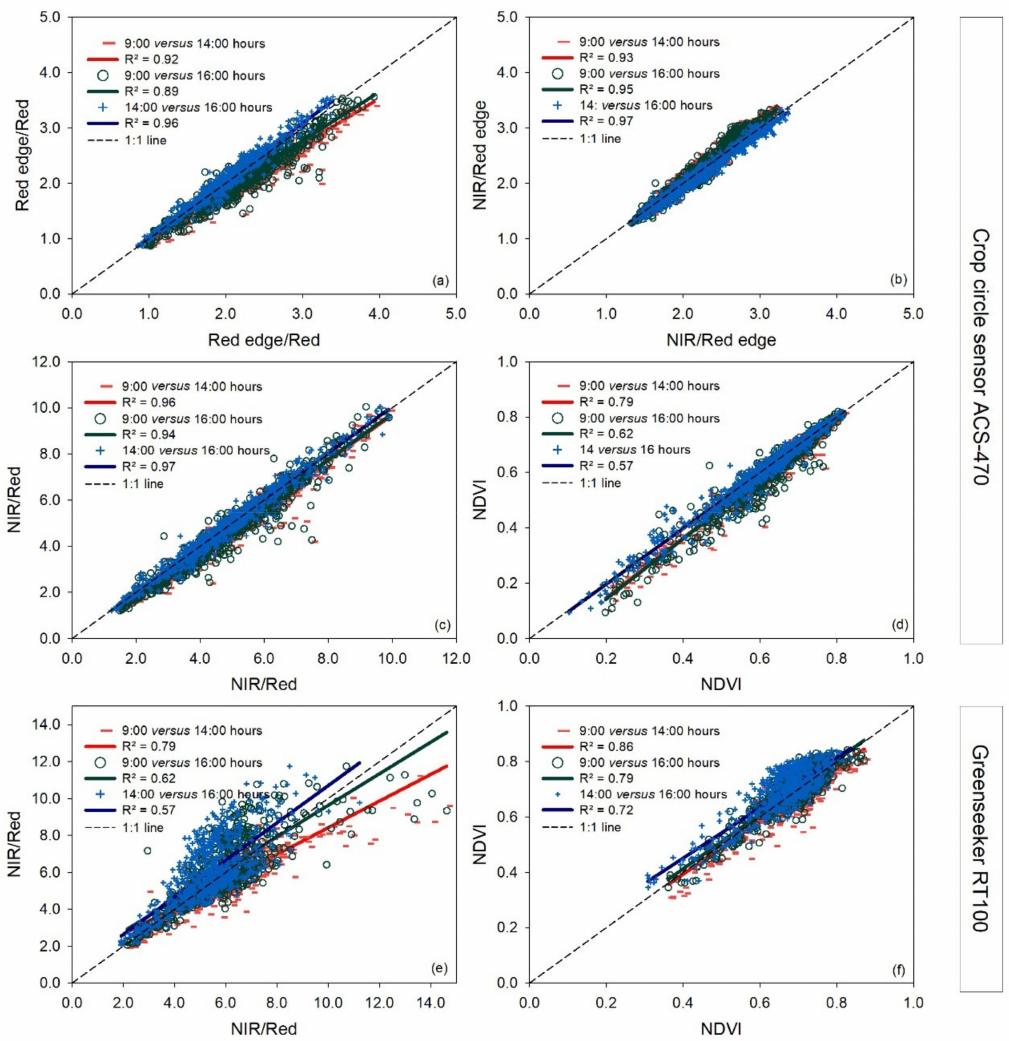
Figure 2. Linear regressions between paired measurement times (9:00 versus 14:00 h, 9:00 versus 16:00 h, and 14:00 versus 16:00 h) for each vegetation index measured with two vehicle-carried active sensors, Crop Circle ACS-470 and Greenseeker RT100, for the three measurement dates together. Panels ( a – d ) show indices calculated with the Crop Circle ACS-470 sensor, and the other panels ( e , f ) show indices calculated with the Greenseeker RT100 sensor. R 2 : coefficient of determination. The dashed line represents the 1:1 line. In the pairwise comparison, the earlier time is indicated on the x-axis and the later time on the